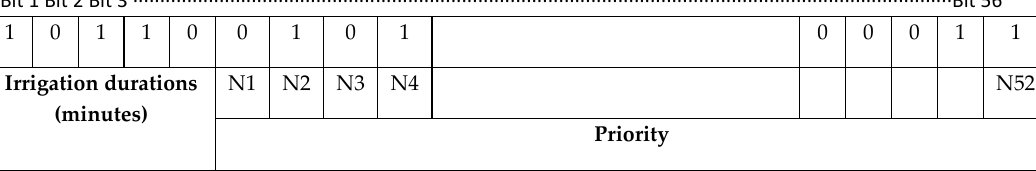
Figure 16. Global system architecture.